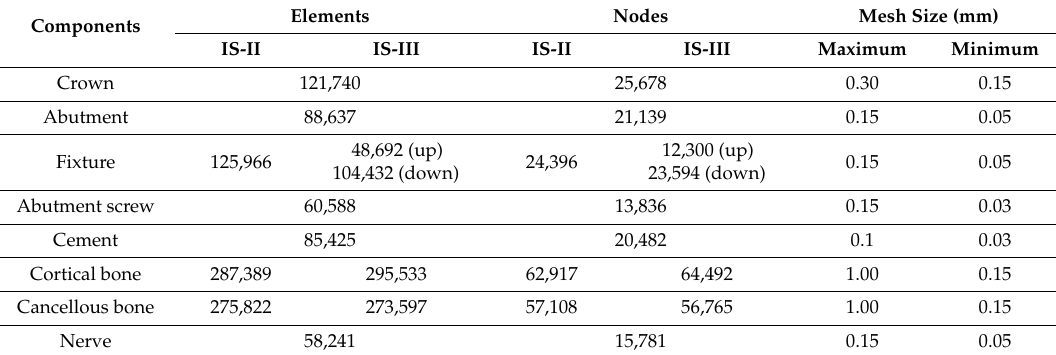
Table 2. Mesh size and number of elements and nodes of the FEA models.